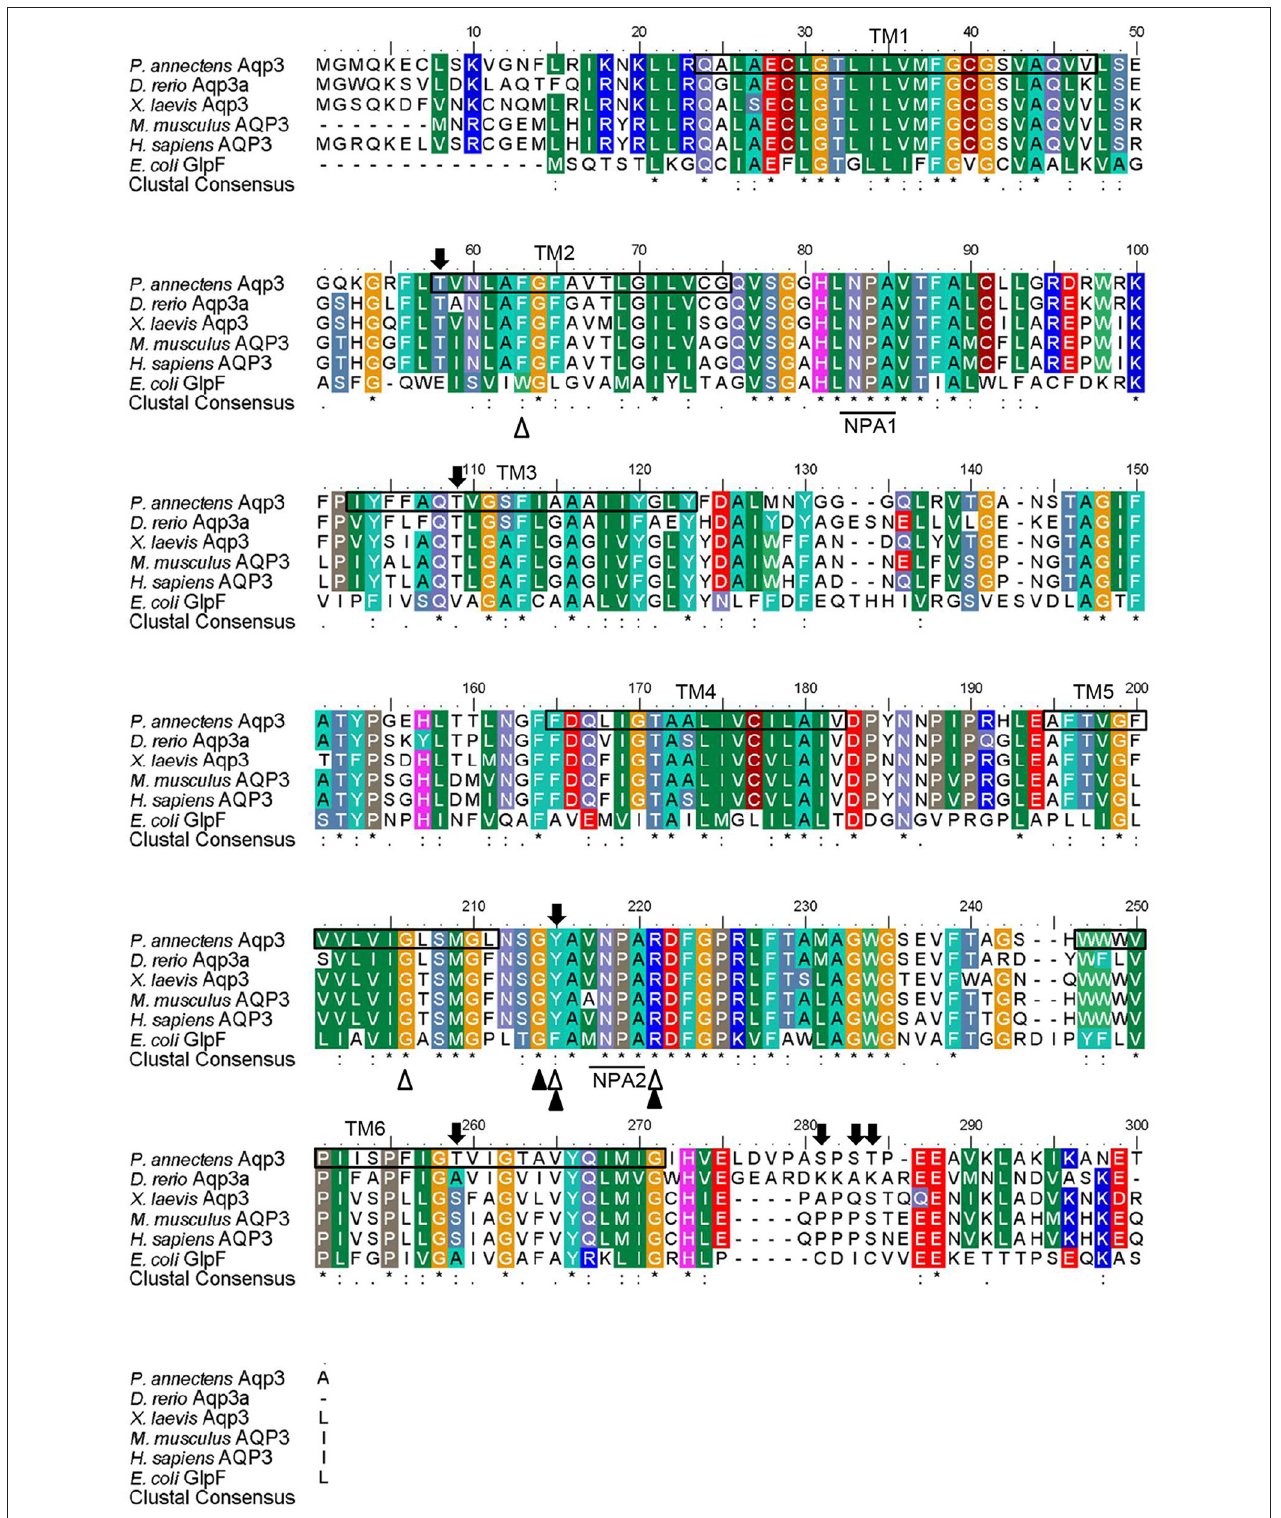
FIGURE 2 | A multiple amino acid alignment of aquaporin 3 (Aqp3) from Protopterus annectens with Danio rerio Aqp3a ( AAH44188.1), Xenopus laevis Aqp3 (NP_001081876.1), Mus musculus AQP3 (BAB03270.1), Homo sapiens AQP3 (AAY68214.1), and Escherichia coli glycerol facilitator (GlpF; BAB03270.1). Identical amino acid residues are indicated by asterisks, strongly similar amino acids are indicated by colons and weakly similar amino acids are